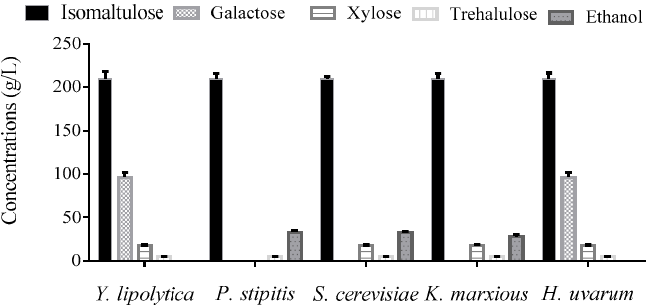
Figure 3. Sugar compositions and ethanol concentrations after bioremoval using di ff erent ethanol producing